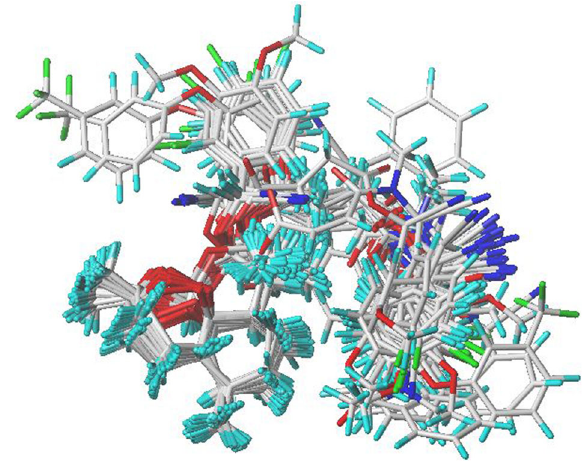
Fig. 1 The alignment of 46 artemisinin